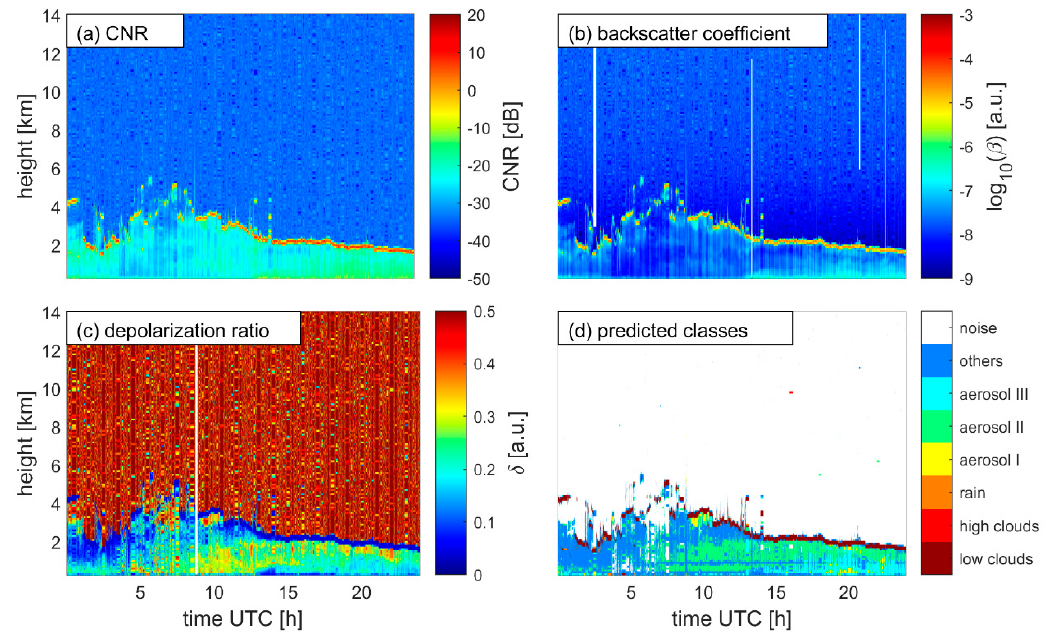
Figure 10. The case with the data collected by the Keflavik lidar: the lidar measurement on 31 July 2019 ( a ) CNR, ( b ) backscatter coefficient, ( c ) depolarization ratio and the machine learning classification result ( d ) predicted classes.